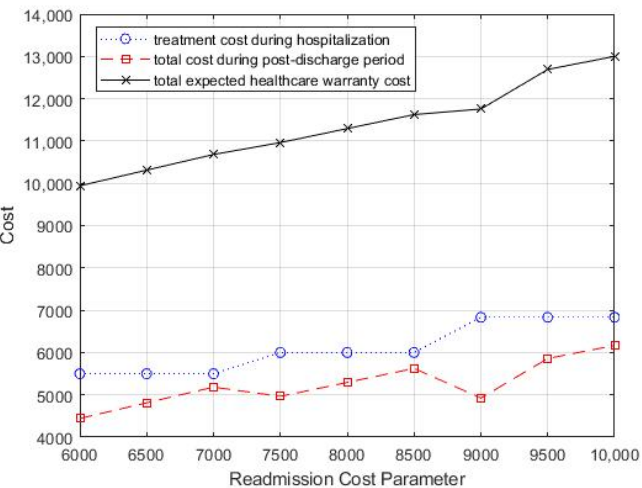
Figure 5. Change in readmission cost parameter, c r , for total costs.